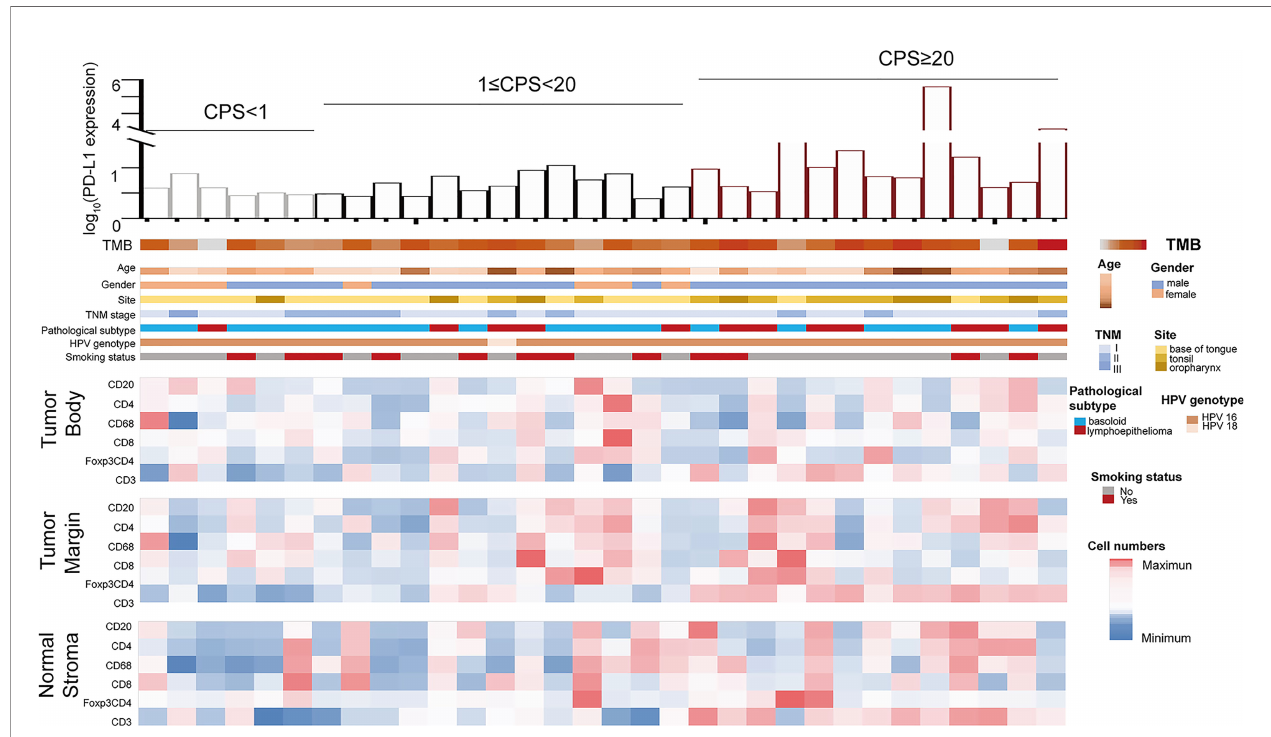
FIGURE 2 | Overview of main fi ndings from mIF, RNA sequencing, and WES analysis classi fi ed by CPS levels. Listed in descending order are PD-L1 RNA expression value, TMB, clinical parameters, mIF immune markers in TB, mIF immune markers in TM, mIF immune markers in